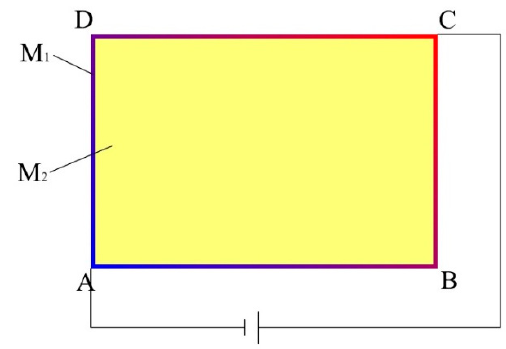
Figure 2. The working schematic diagram of L 1 .